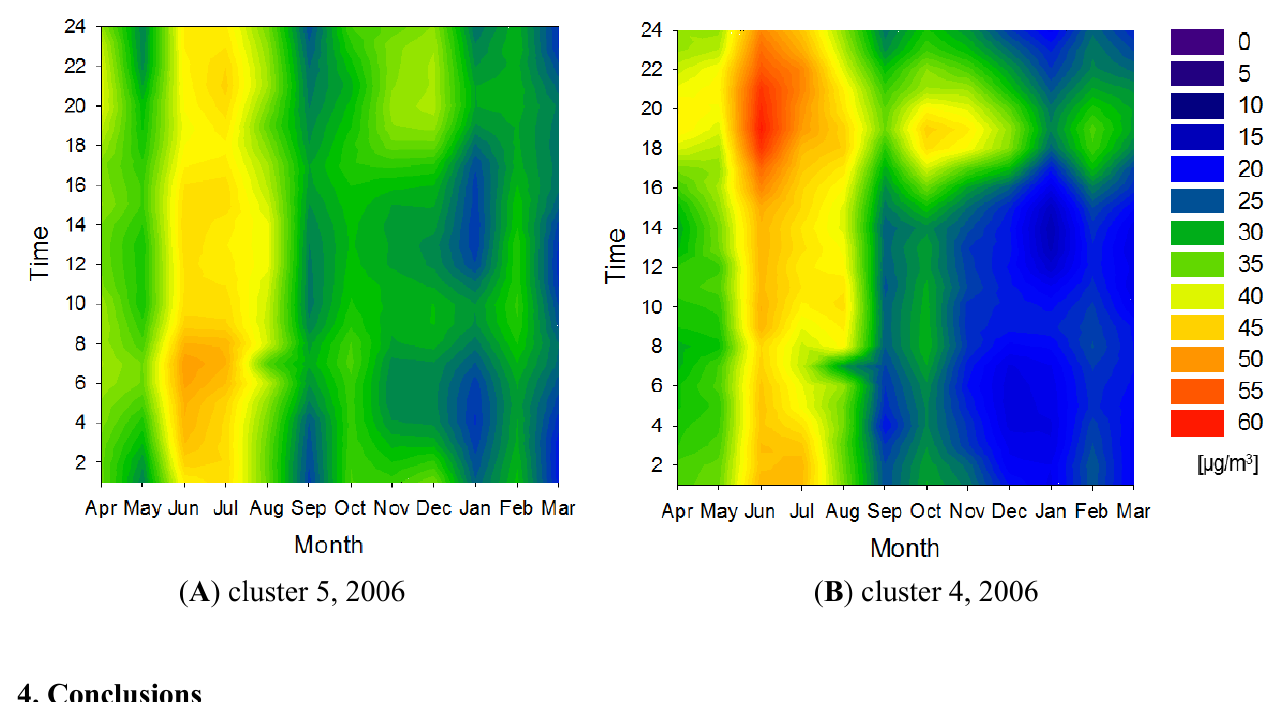
Figure 10. SPM concentration contour maps for clusters 5 ( A ) and 4 ( B ) in